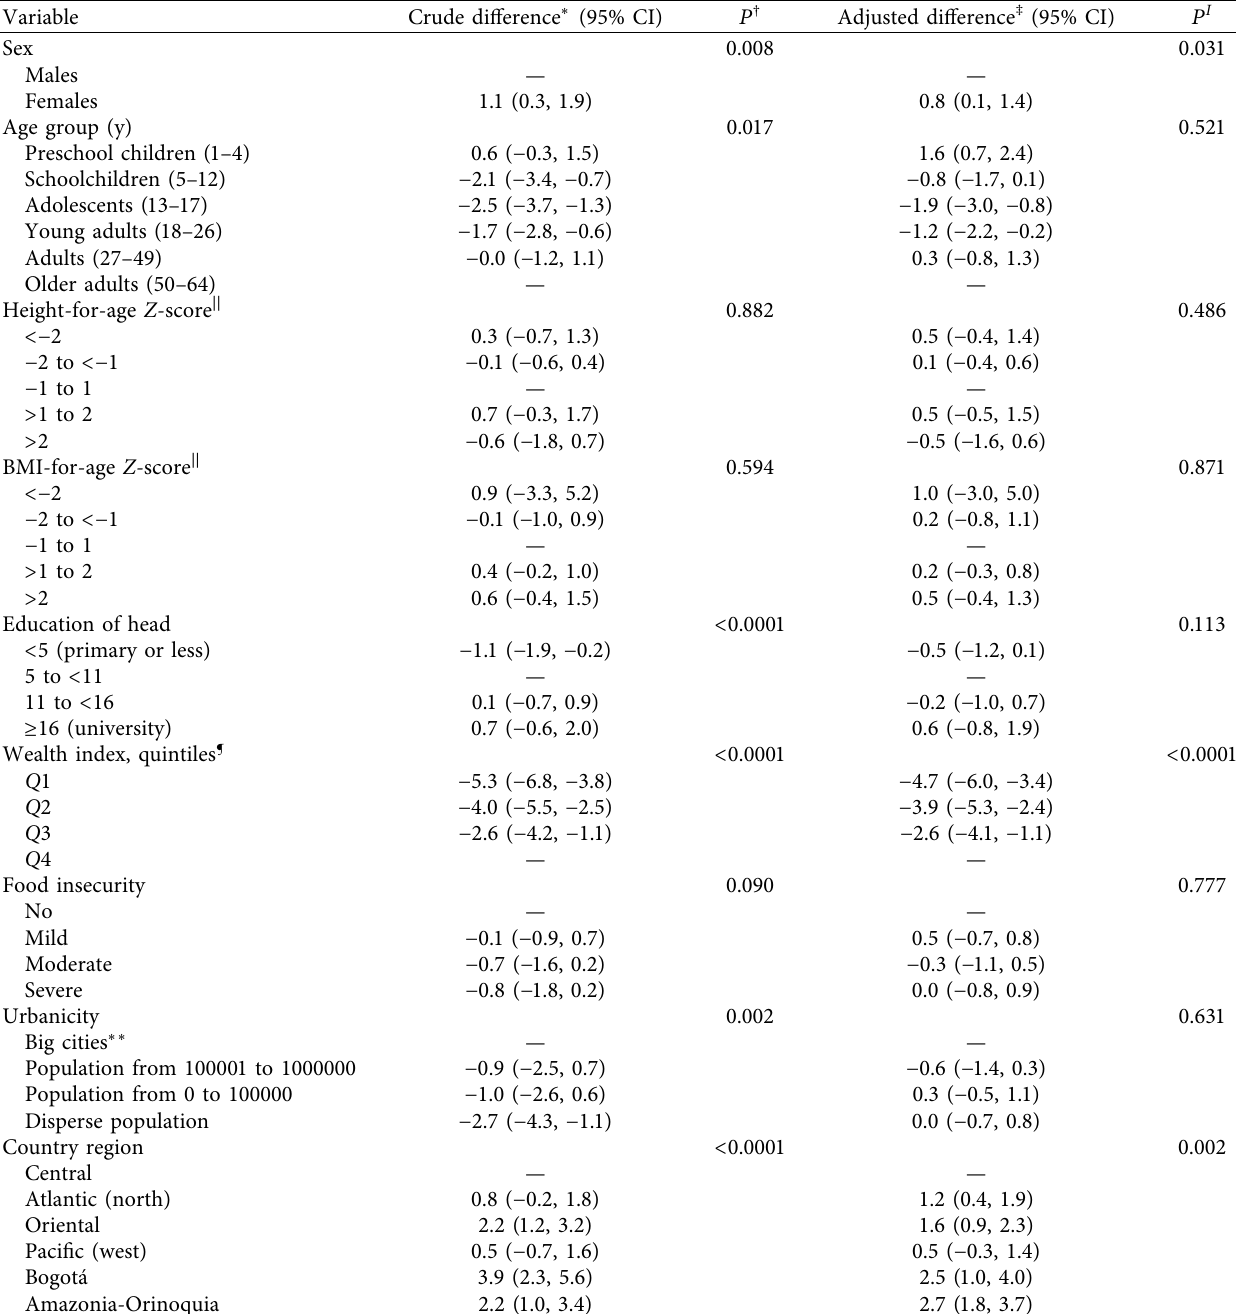
Table 2: Differences in animal protein intake, g/d for every 1000kcal consumed in Colombian population (aged from 1 to 64